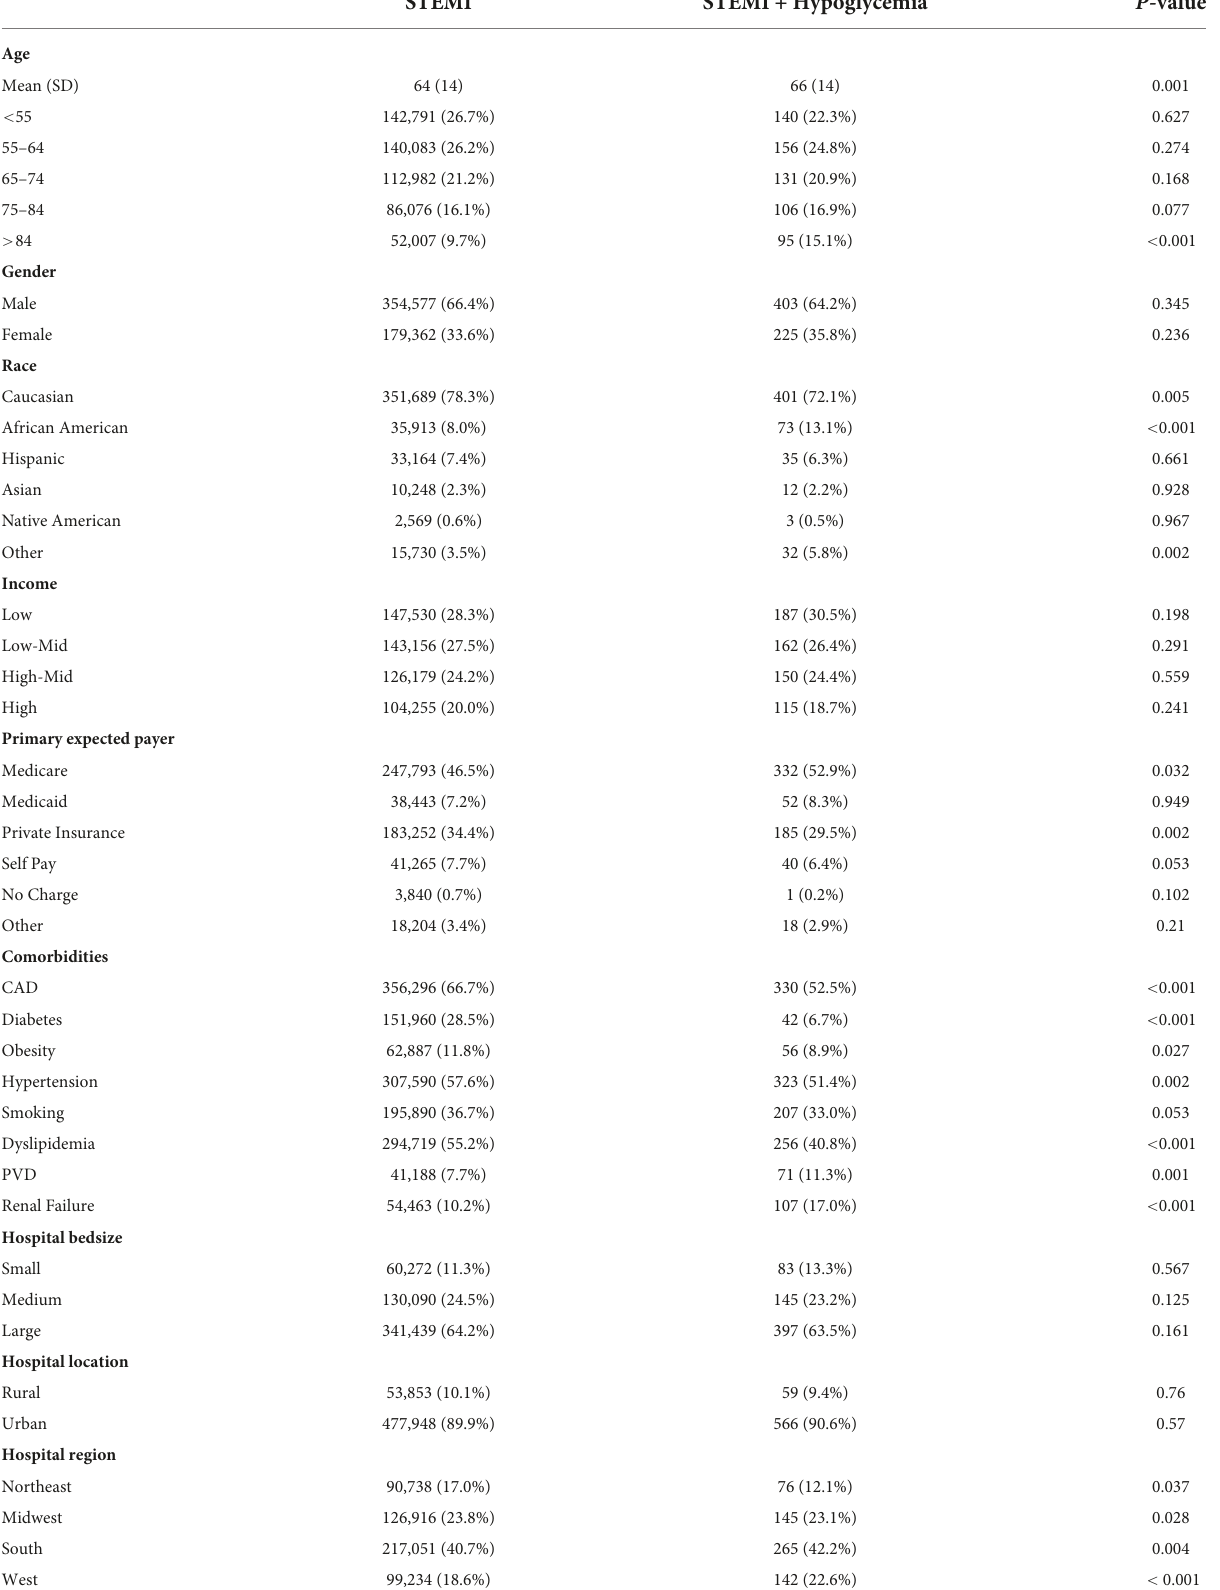
TABLE 2 Comparison of baseline characteristics of STEMI patients according to the presence of hypoglycemia. STEMI STEMI + Hypoglycemia P